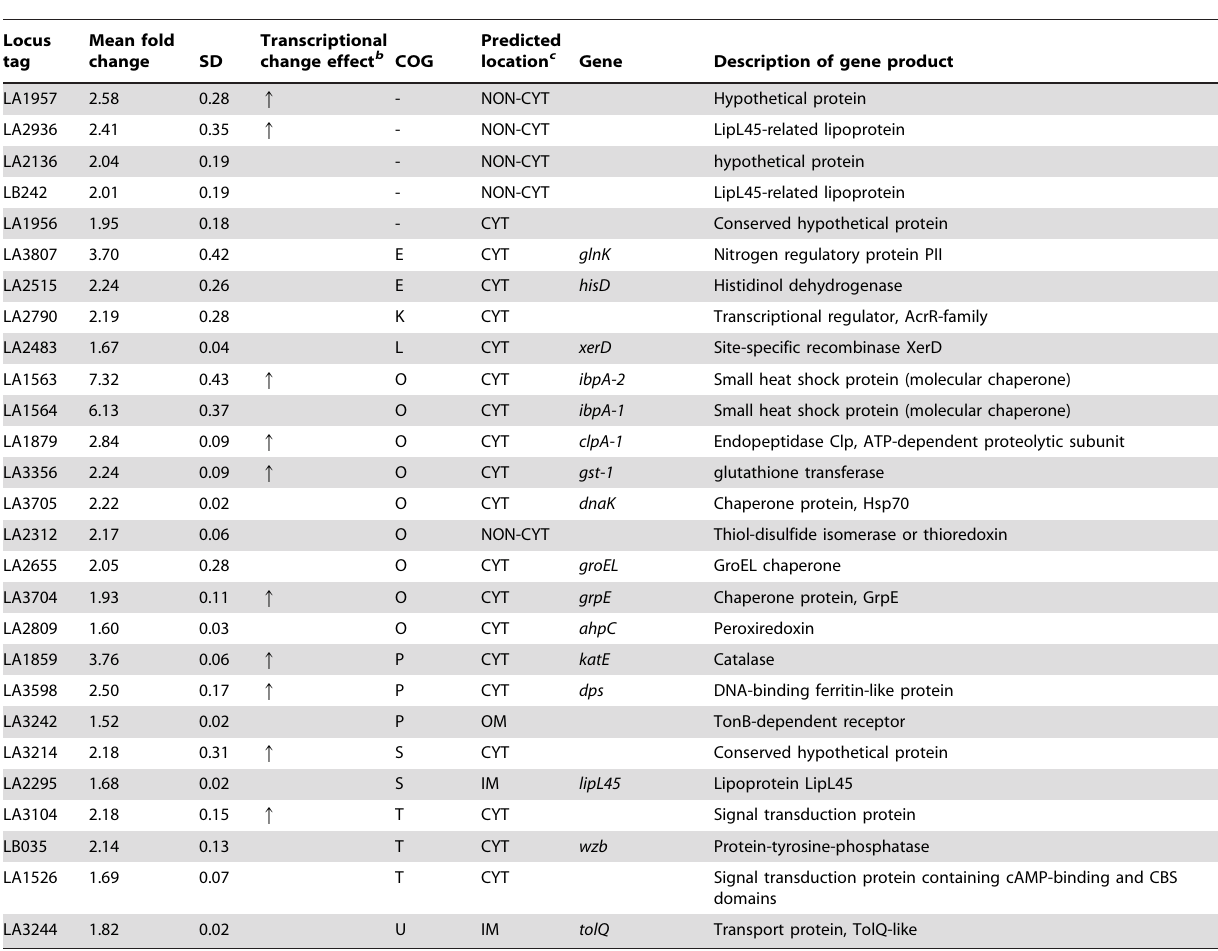
Table 2. Proteins which were at least 1.5-fold up-regulated at 37 u C upshift compared to 30 u C grouped by COG category. The clusters of orthologous groupings a (COGs) [47] are shown for each protein. The change in transcription at 37 u C upshift versus 30 u C is shown for comparison with the proteomic